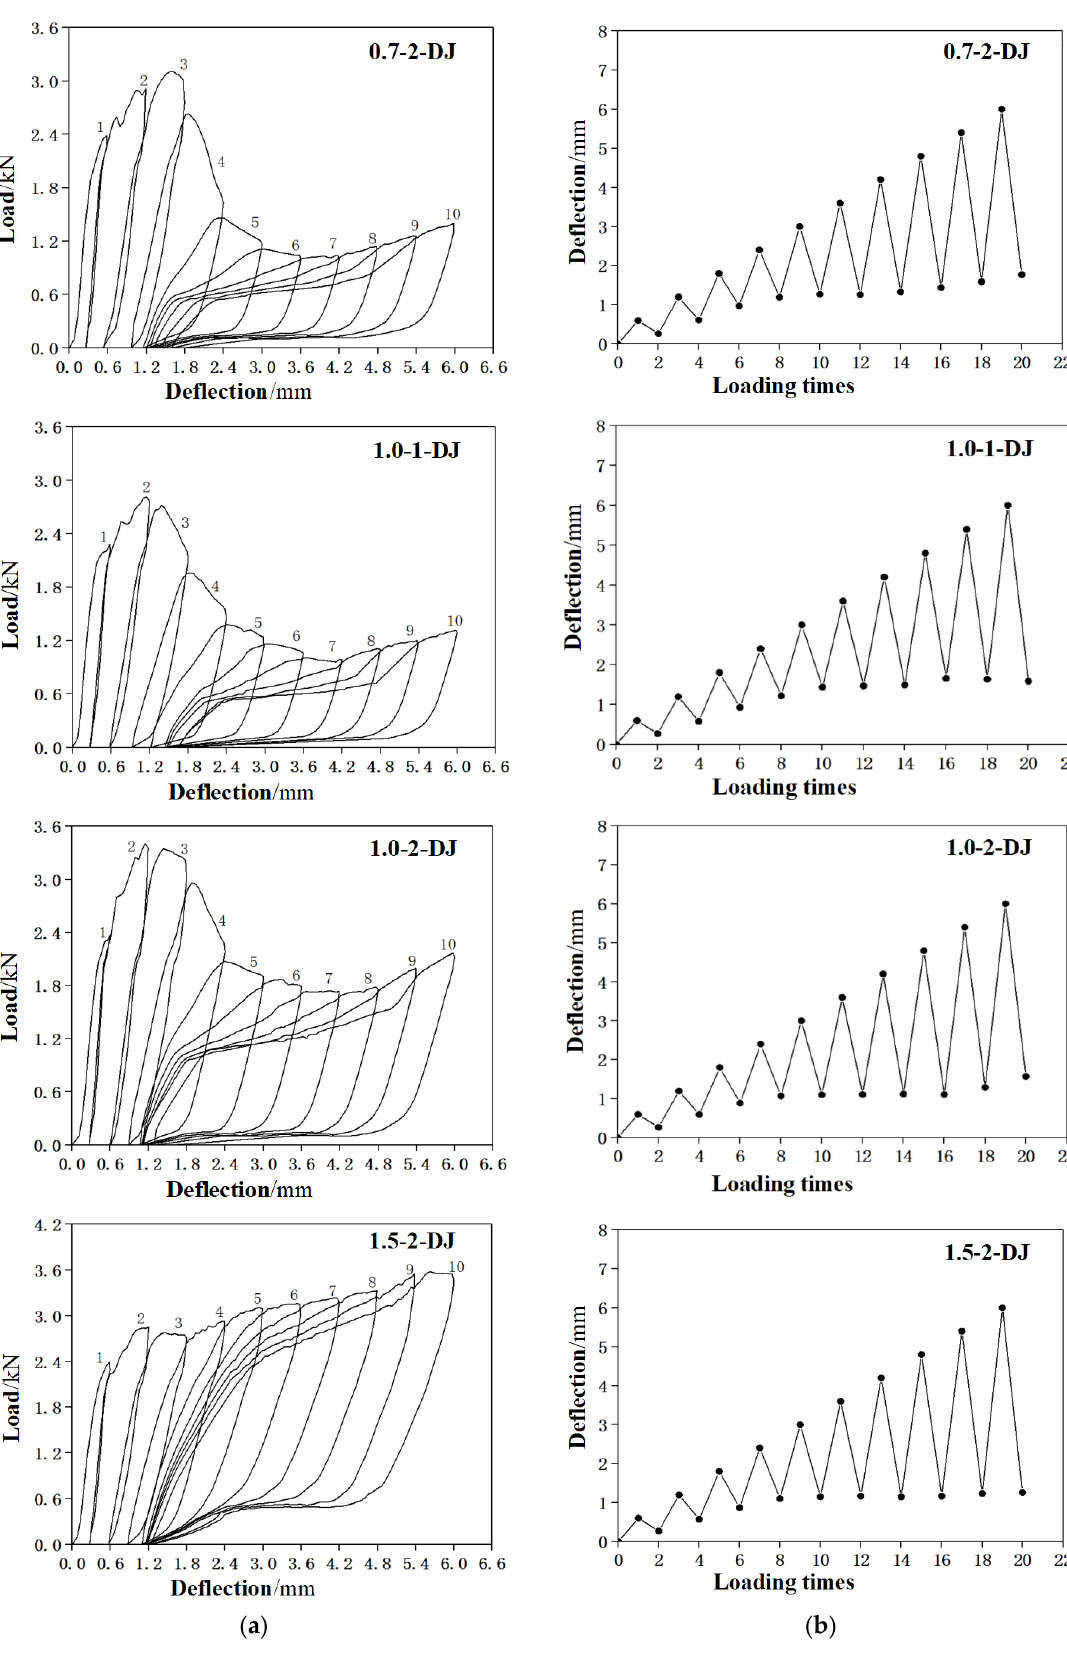
Figure 10. The load-deflection curves and deflection recovery curves: ( a ) load-deflection curves; ( b ) deflection recovery curves.